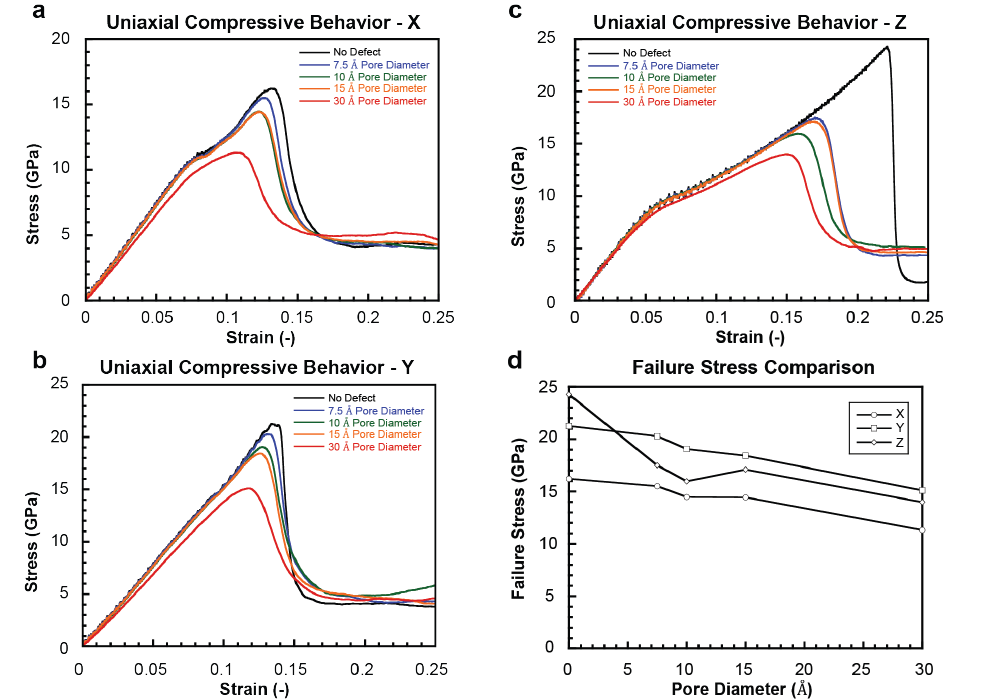
Figure 4. Effect of pore inclusion on HAP compressive mechanical response. ( a – c ) X, Y, and Z direction stress–strain curves for monocrystalline HAP with and without pores, respectively. ( d ) Measured failure stress for each loading direction as a function of pore